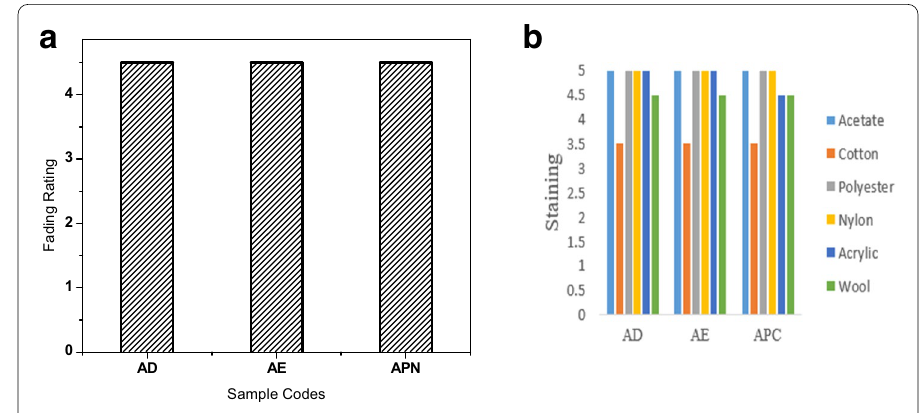
Fig. 6 Color fastness to washing a Fading rating. b Staining rating. AD After Dyeing, AE After Enzyme, APN After PP Followed by PP